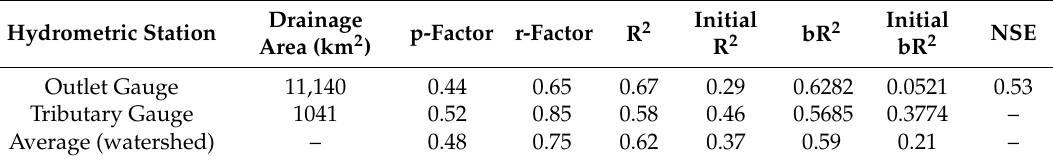
Table 2. Final combined summary statistics for the calibrated and validated SWAT model. Initial refers to prior to calibration.